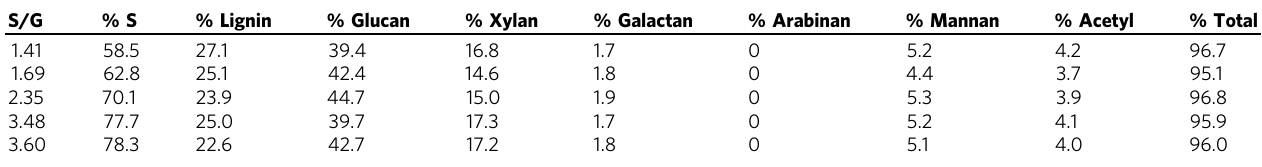
Table 1 Compositional analysis of poplar natural genetic variants S/G % S % Lignin